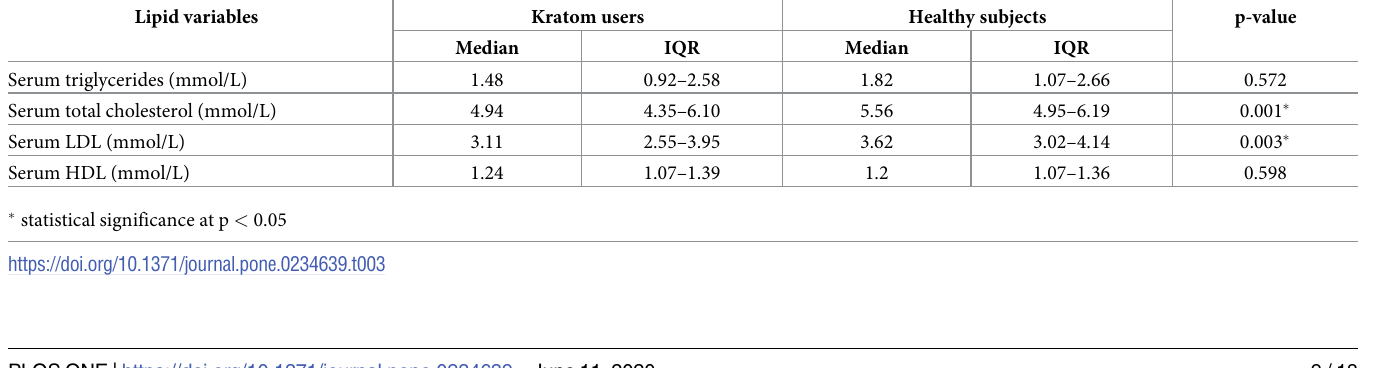
Table 3. Fasting lipid profile of the participants. Lipid